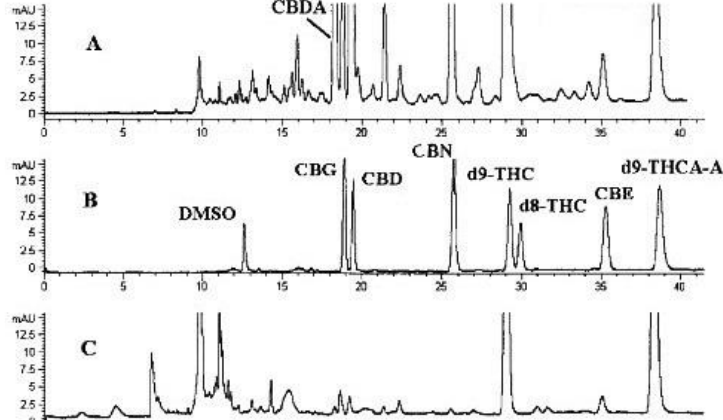
Figure 5. CEC separation of cannabinoids in ( A )—concentrated hashish extract, ( B )—standard mixture, ( C )—concentrated marijuana extract (analytical conditions: 3- µ m CEC Hypersil C18 capillary, 25 mM phosphate in acetonitrile, pH 2.57, 20 ◦ C, 25 kV, electrokinetic injection 5 kVx 3 sec,